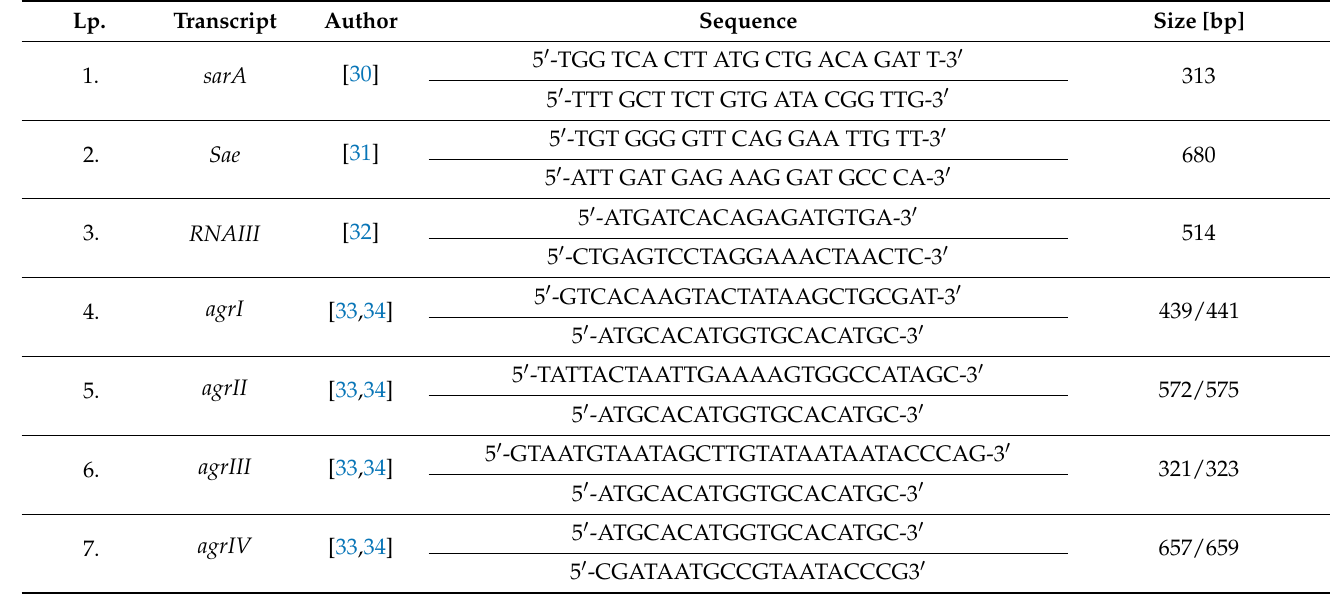
Table 2. Primers used for PCR analysis of genes responsible for regulation of virulence.